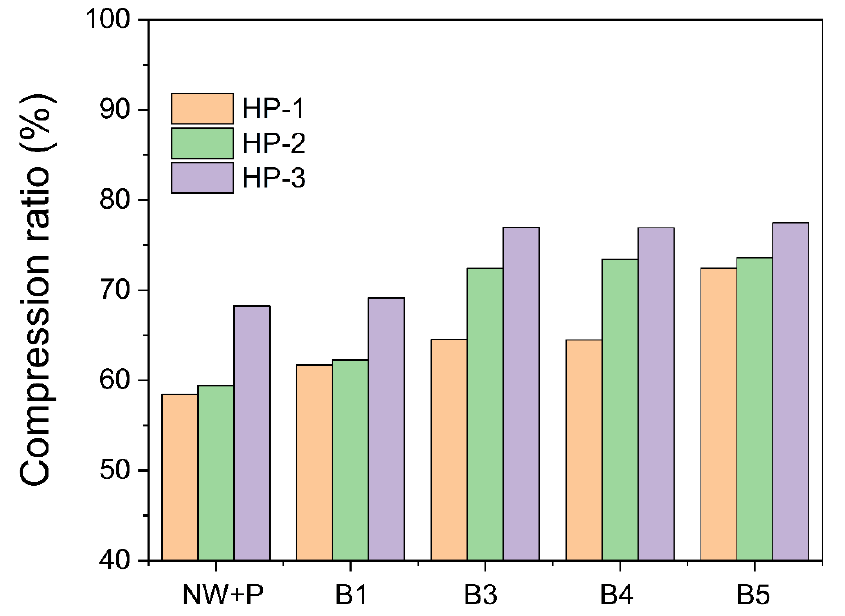
Figure 5. Compression ratios of the wood specimens under different hot-pressing